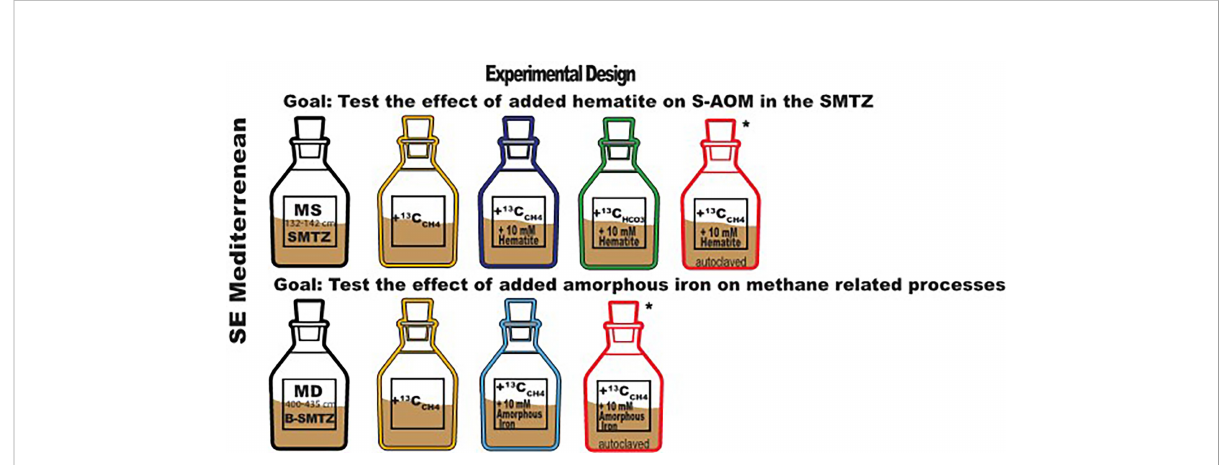
FIGURE 1 Experimental design. Treatments for SMTZ sediments of SE Mediterranean Sea (MS) shelf; Treatments for deep iron-rich sediments of SE Mediterranean Sea (MD); Yellow bottles represent amendments of 13 C CH4 (natural controls); dark blue represents amendments of 13 C CH4 and 10 mM of hematite; green represents 13 C HCO3, and 10 mM of hematite amendments; light blue represents 13 C CH4 and 10 mM of amorphous iron; and red (marked*) the killed